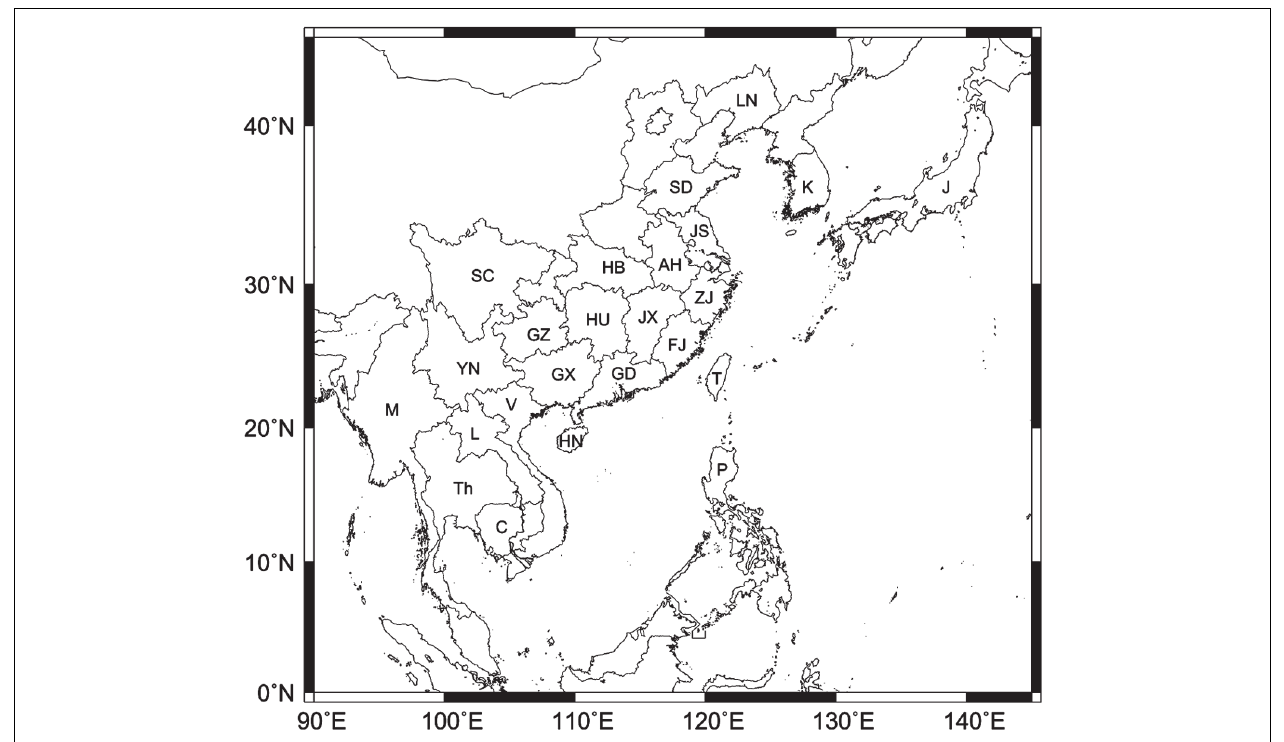
FIGURE 1 | Locations of Chinese provinces and EastAsian countries of interest . Abbreviations LN, SD, JS, AH, ZJ, HB, JX, FJ, HU, GD, GZ, GX, HN, SC,T, P,V, C, L,Th, M, K, and J indicate Liaoning, Shandong, Jiangsu, Anhui,